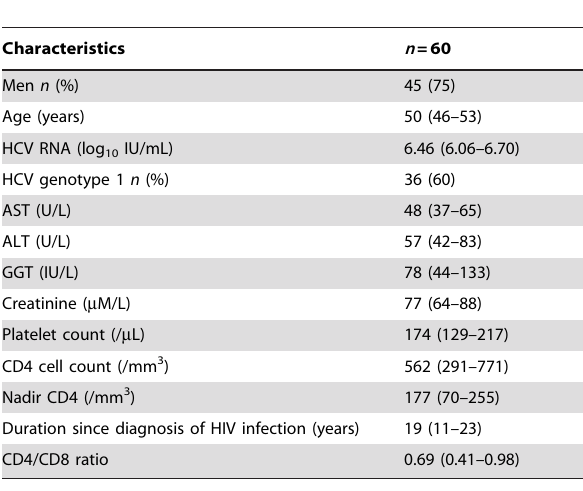
Table 1. Characteristics of HIV/HCV co-infected patients ( n =60).